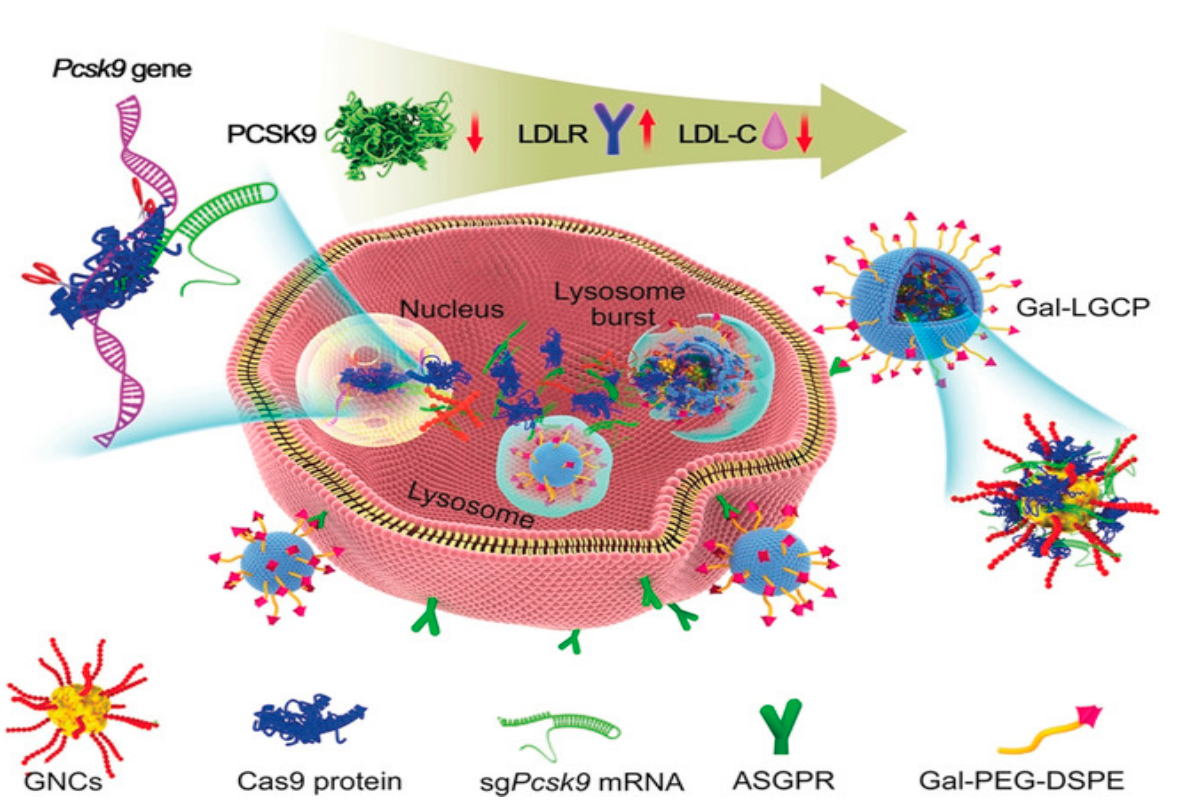
Figure 4. Gold NP coated with lipid for target delivery of CRISPR/Cas9. Reprinted with permission from ref [41]. Copyright 2019, John Wiley and Sons.